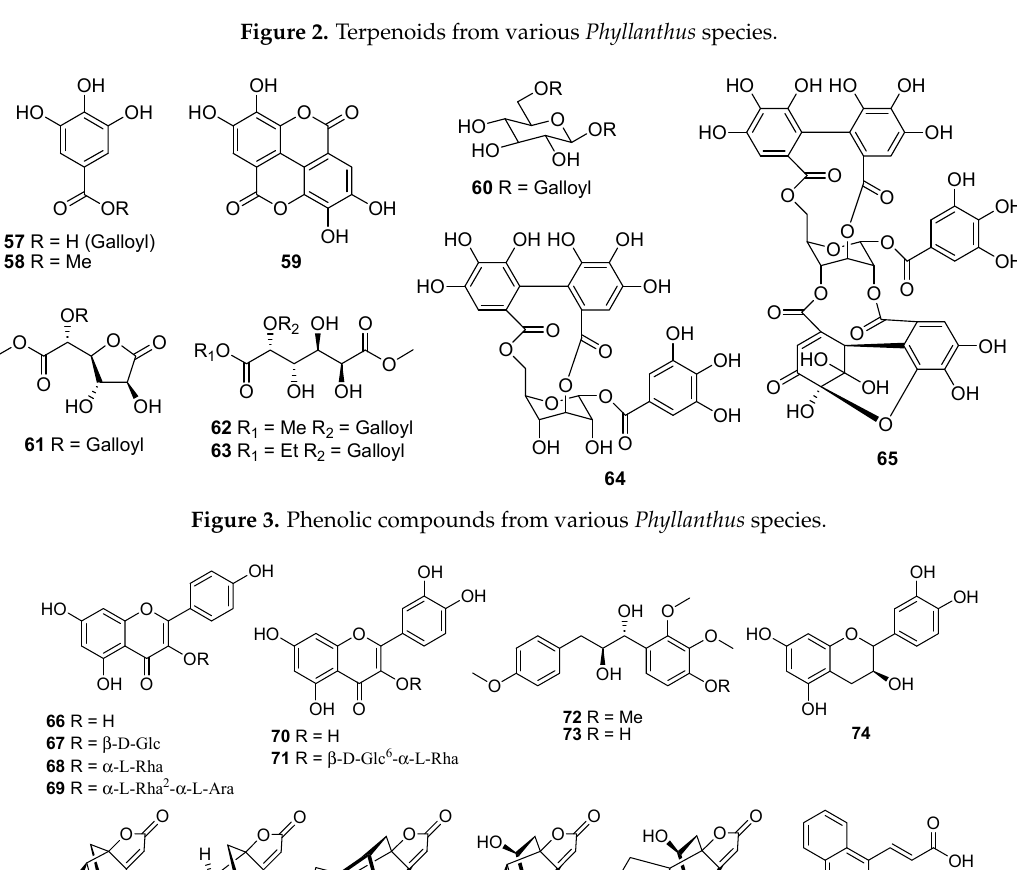
79 Figure 4. Flavonoids, alkaloids and other compounds from various Phyllanthus species. 2.6. Other Compounds Compound 80 (Figure 4), belonging to the naphthalene acetic acid class, is present in P. amarus and P. urinaria [24]. Moreover, constituent 81 (PEPW80-1) belongs to the polysaccharides, and was isolated from P. niruri [38]. HPLC–MS is a powerful analytical tool, which could efficiently characterize the chemical composition of various Phyllanthus species. Detailed and pioneering explorations of the phenolic compounds in P. acuminatus L. and P. niruri L. were done, which unravelled the presence of nearly 40 different phenolic derivatives for the first time in these Phyllanthus species, including pinocembrin isomers, apigenin derivatives, chrysin, quercetin, kaempferol, ellagitannins, prodelphinidin B dimer, epi -gallocatechin, ellagic acid, trimethylellagic acid, and ferulic acid [39,40]. One recent extensive study confirmed the presence of various phenol, flavonoid, non-flavonoid, tannin, alkaloid, saponin, and phytosterol phytochemicals in dried P.